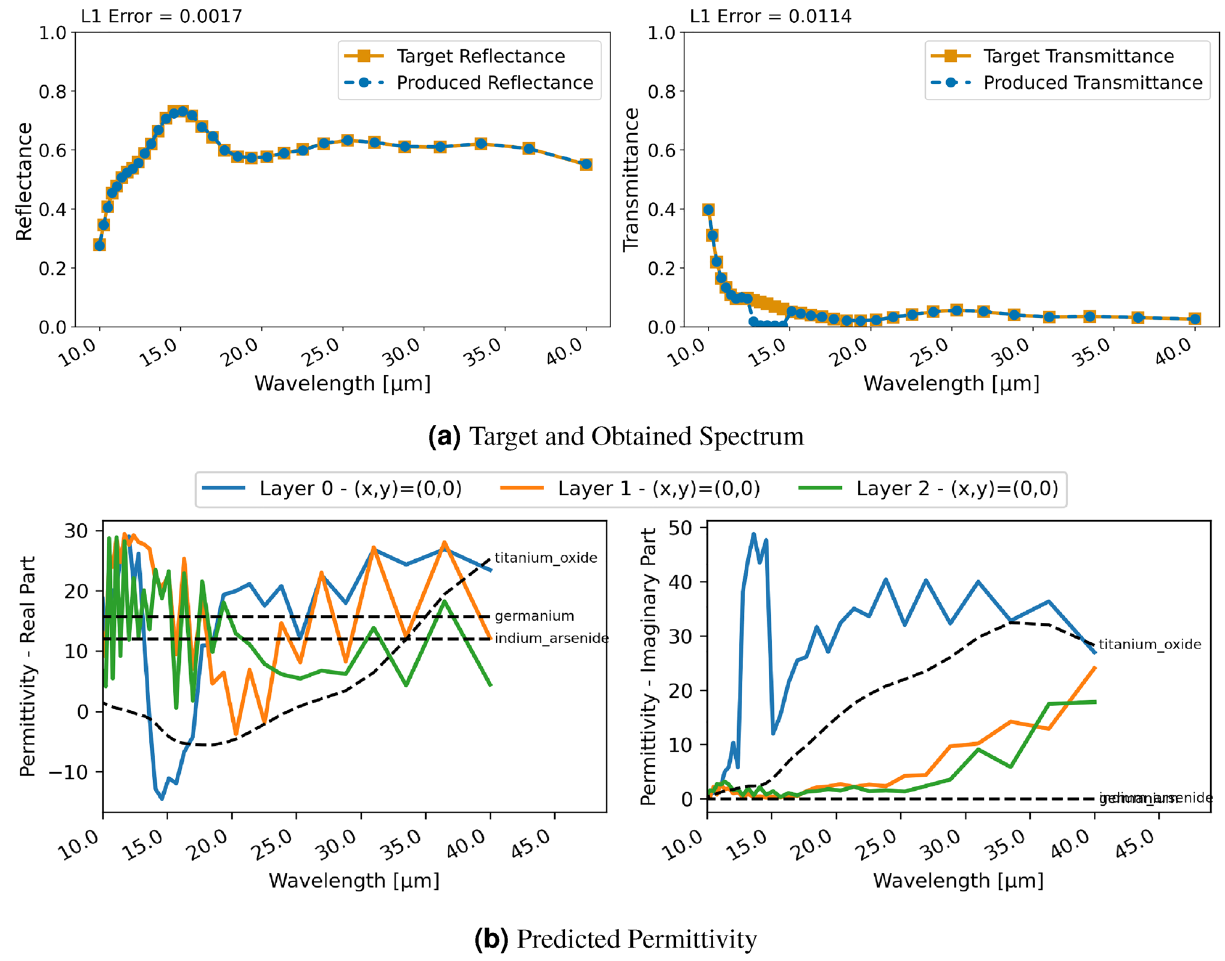
Figure 5. Inversion results for a three-layer material using RCWA and regression; ( a ) displays target and produced spectra, ( b ) shows the utilized permittivity for each